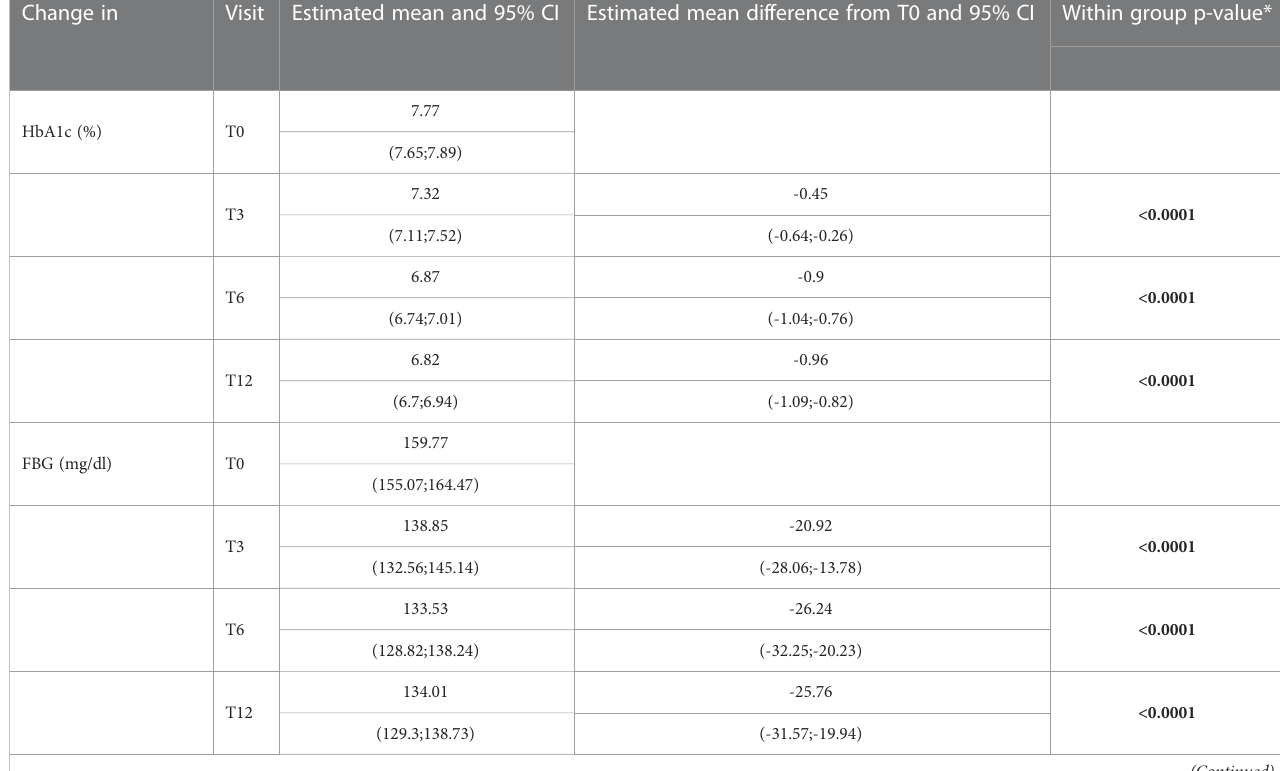
TABLE 2 Changes in estimated mean levels of continuous clinical endpoints over time. Change